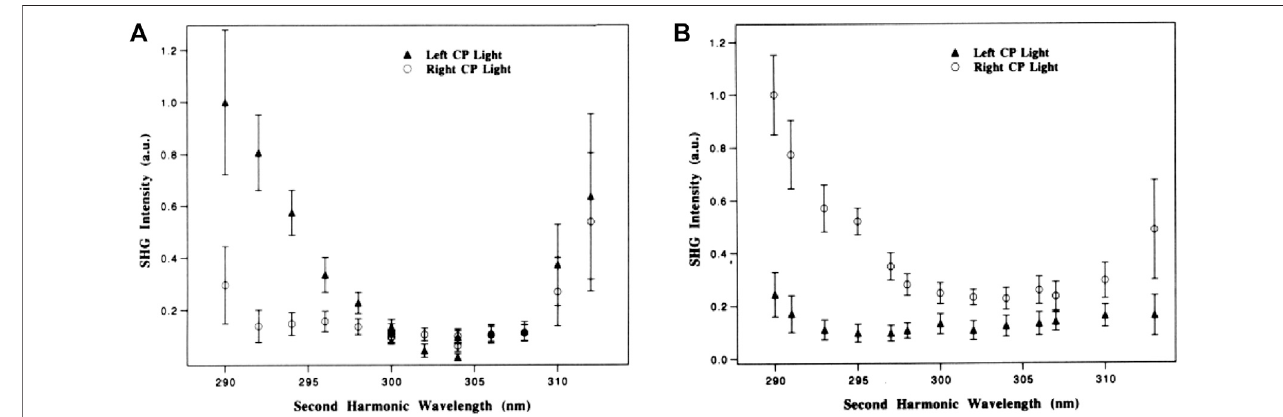
FIGURE8|(A) RelativeSHGef fi cienciesasthelaserfrequencyisvaried,plottedasafunctionofthesecond-harmonicwavelengthforthe R enantiomerofBNusing leftcircularlypolarized( ▲ )andrightcircularlypolarized( ○ )light.Intensityfromneatwater:0.01au. (B) RelativeSHGef fi cienciesasthelaserfrequencyisvaried,plottedas afunctionofthesecond-harmonicwavelengthforthe S enantiomerofBNusingleftcircularlypolarized( ▲ )andrightcircularlypolarized( ○ )light.Intensityfromneatwater: 0.05 au. The fi gure and caption have been adapted with permission from Petralli-Mallow et al., (1993), Copyright © 1993 American Chemical Society.